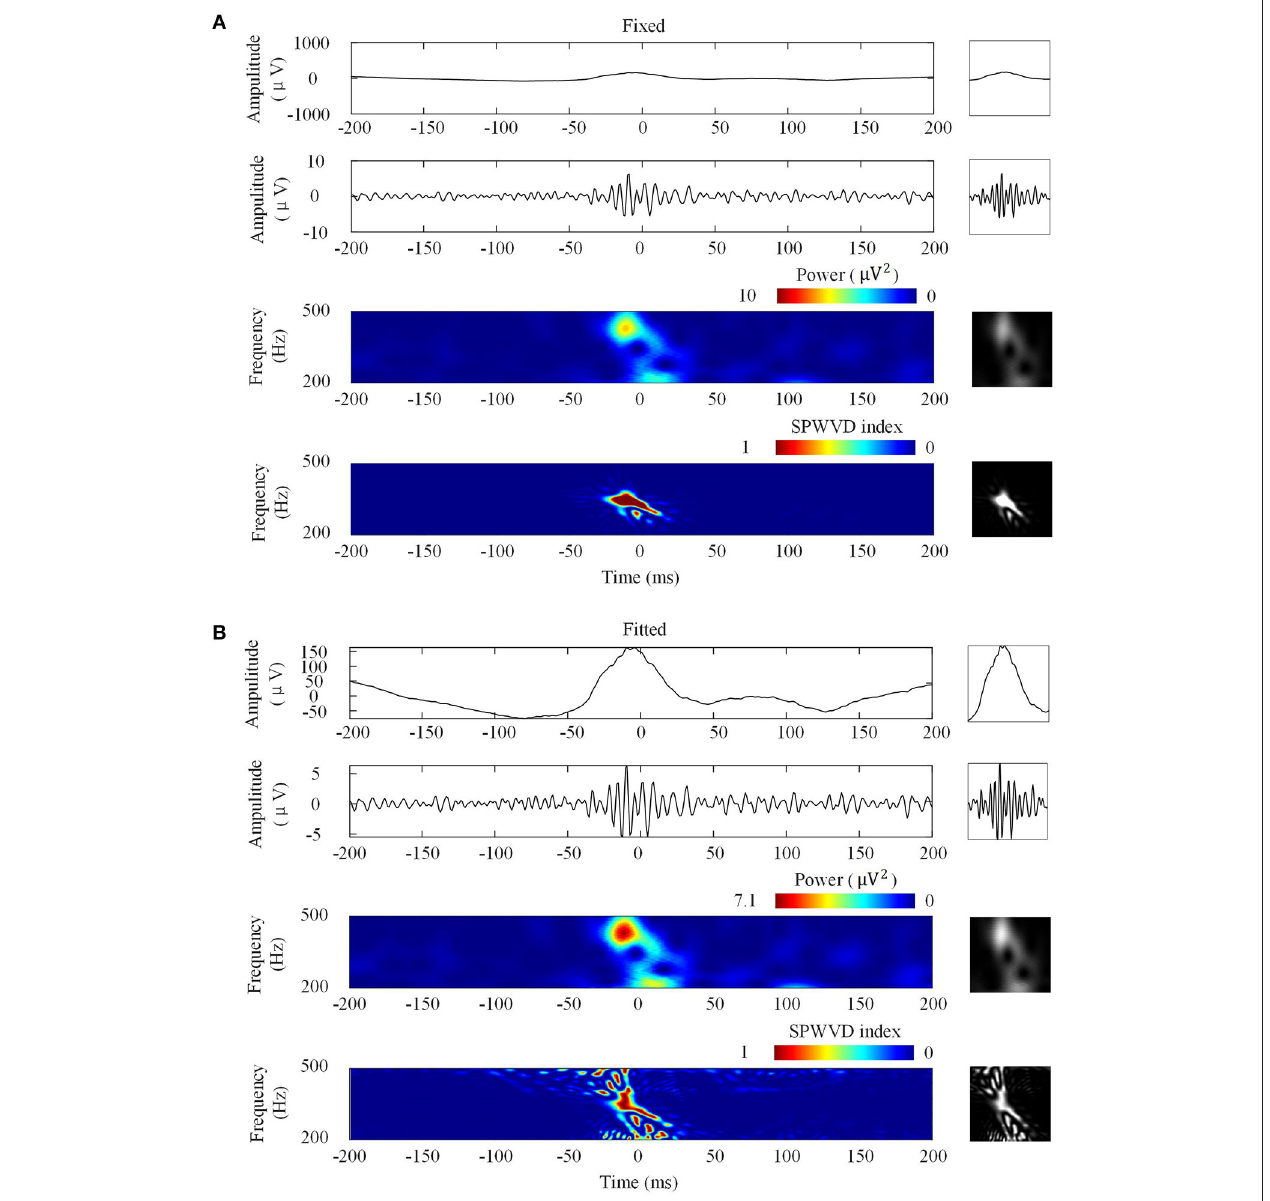
FIGURE 4 | Four fast ripples (FRs) image transformations. Left: Transformations of a FR. Right: Network inputs in the form of two-dimensional pictures of 96 × 96 pixels that represent various transformations. (A) Transformations with fixed scales. From top to bottom are original waveforms, filtered (200–500Hz) waveforms, wavelet spectrum images, and ASPWVD spectrum images. (B) Transformations with fitted scales. From top to bottom are original waveforms, filtered (200–500Hz) waveforms, wavelet spectrum images, and re-normalized SPWVD spectrum images.